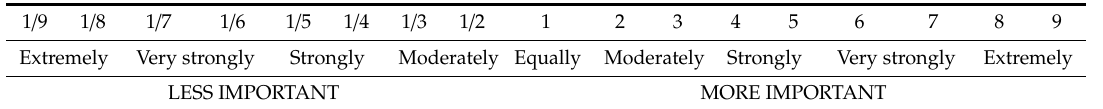
Table 2. Scale of the relative importance of two criteria 1 .